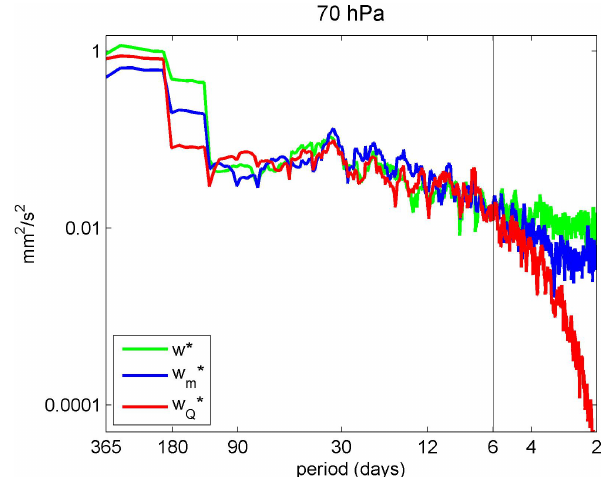
Fig. 8. Power spectra of the three upwelling estimates at 70hPa as a function of log-frequency. An 11-point running mean was applied to the spectra (mm 2 s − 2